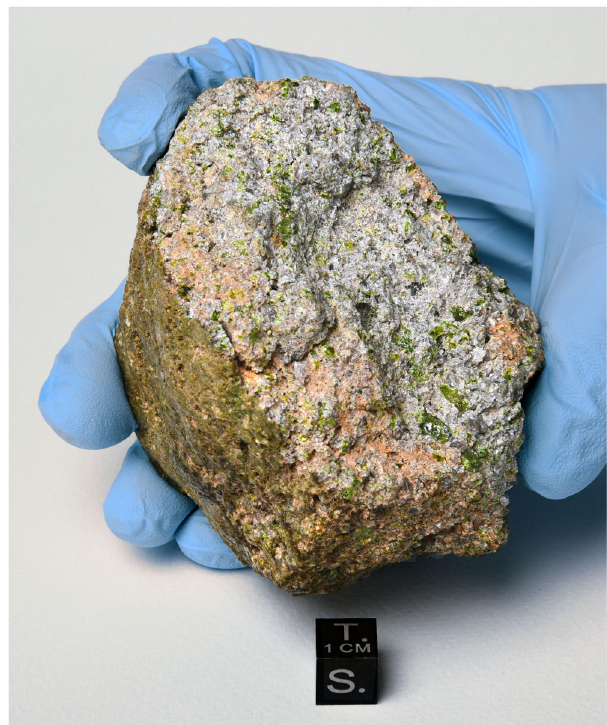
Fig. 1 Photograph of the main mass of NWA 11119 that was found in Mauritania in December 2016. The rock has a light-green fusion crust, and the broken interior shows light-green and gray-colored crystals. Photo